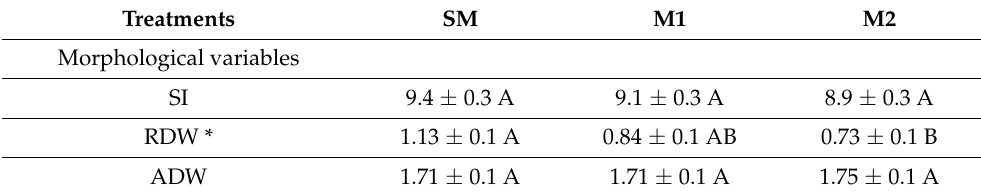
Table 1. Mean and standard deviation for the morphological variables: slenderness index (SI), root dry weight (RDW, g), aerial dry weight (ADW, g). Stars indicate the significance level. Significance levels: * <0.05; <0.1. Different letters indicate significant differences, according to Kruskal–Wallis test with α :